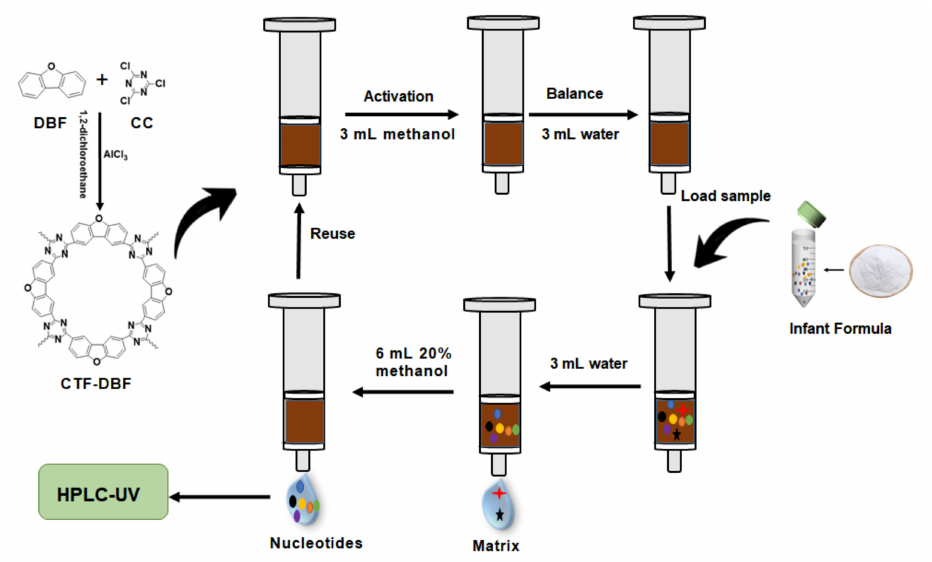
Figure 2. Schematic of this